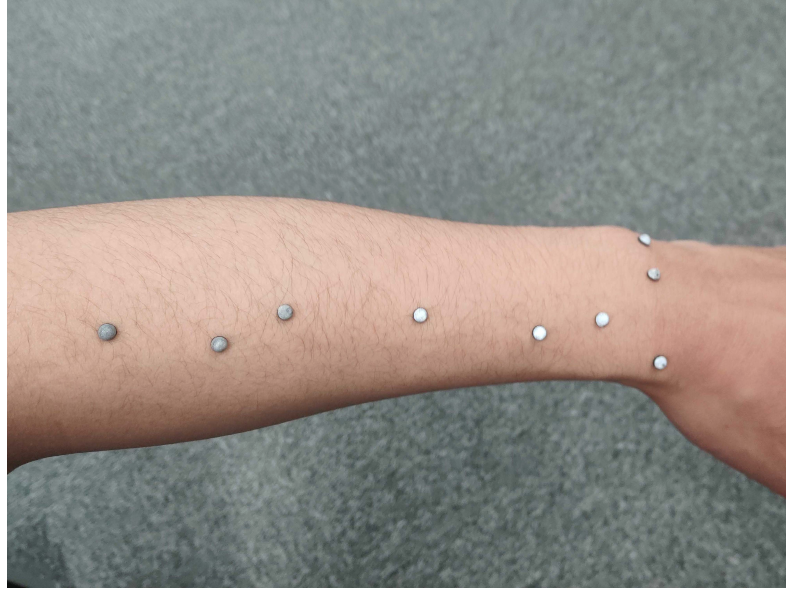
Figure 6. Markers attached to the forearm for data